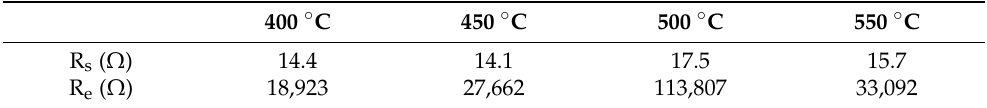
Figure 16. Electrochemical test results of the coating at different spraying temperatures: ( a ) Nyquist diagram, ( b ) equivalent circuit model diagram. Table 4. EIS fitting results of Al – Zn composite coating at different spraying temperatures in 3.5 wt % NaCl solution at the initial immersion stage.